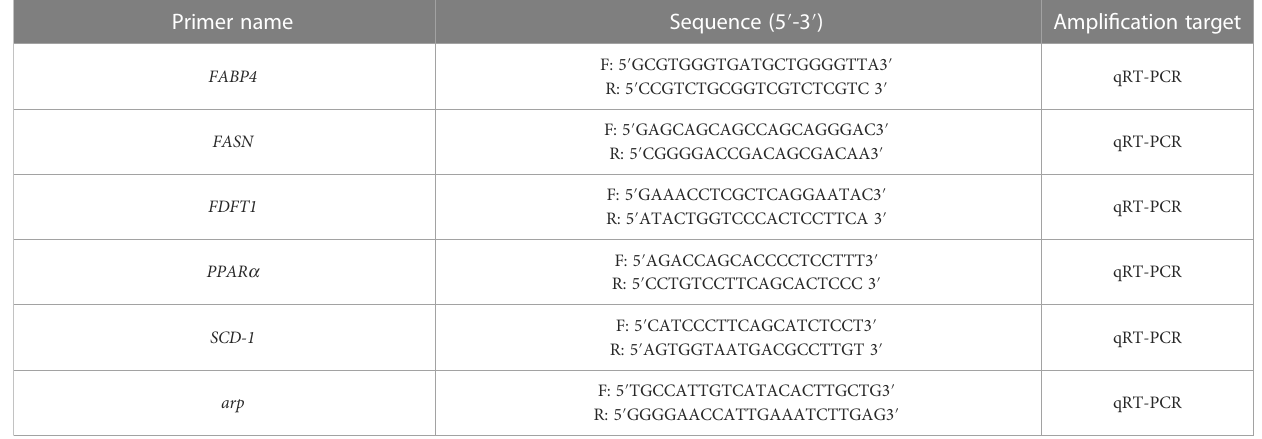
TABLE 1 Primers used to validate the analysis of selected